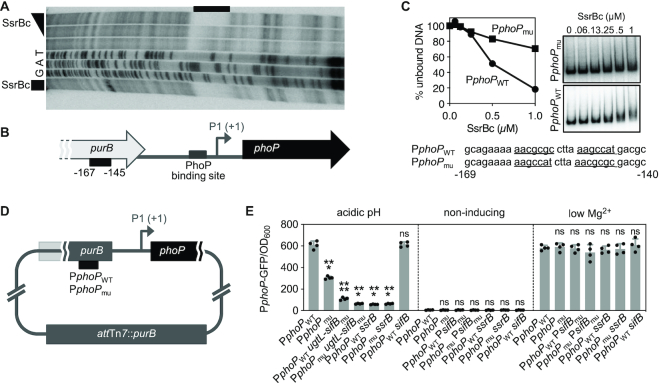
SsrB promotes phoP transcription by binding to the purB coding region upstream of the phoP promoter. (A) DNase I footprinting analysis of the phoP promoter using purified SsrBc-His6 protein (0, 0.25 and 1 μM, triangle; 1 μM, square). Lanes G, A and T correspond to dideoxy chain-termination sequences for the phoP promoter DNA. The black bar indicates the region protected by the SsrBc-His6 protein. (B) Schematic of the purB-phoP chromosomal region. The SsrB binding site is located in the coding region of the purB gene. Numbers under the black box indicate distance from the +1 (P1, PhoP-activated transcriptional start site). (C) In vitro binding of SsrBc-His6 to the wild-type or mutant SsrB binding site DNAs. DNA (2 nM) was incubated with SsrBc-His6 proteins (0, 0.06, 0.13, 0.25, 0.5 and 1 μM). A representative of at least three independent experiments is shown. Numbers underneath the nucleotides indicate distance from P1. (D) Schematic of strains with wild-type (PphoPWT) or mutated (PphoPmu) SsrB binding site in the purB coding region (on the purB gene which is inactivated) and a copy of purB gene integrated into attachment Tn7 site. (E) Fluorescence produced from a PphoP-gfp transcriptional fusion displayed by PphoPWT (JC1482), PphoPmu (JC1458), PphoPWTugtL-sifBmu (JC1582), PphoPmuugtL-sifBmu (JC1583), PphoPWTssrB (JC1463), PphoPmussrB (JC1464), and PphoPWTsifB (JC1586) Salmonella grown to mid-log phase in N-minimal media with 1 mM of Mg2+ at pH 4.9 (acidic pH), 10 μM Mg2+ at pH 7.6 (low Mg2+), or 1 mM Mg2+ at pH 7.6 (non-inducing). The mean and SD from four independent experiments are shown. One-way ANOVA with Brown-Forsythe and Welch tests (PphoPWT vs. others); ns, not significant; ***P < 0.001, ****P < 0.0001.